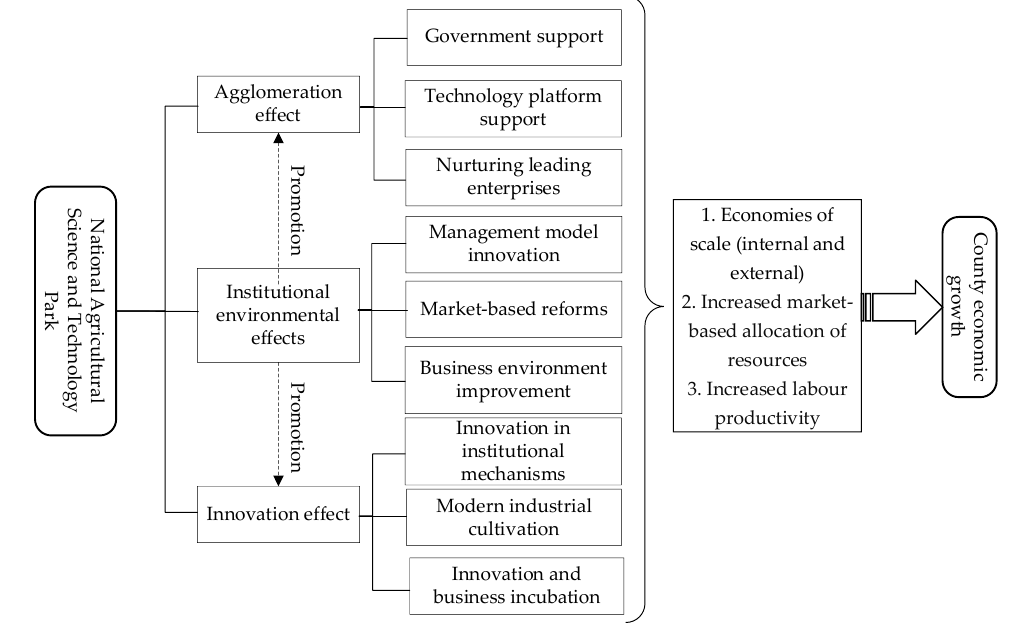
Figure 1. Theoretical analysis framework.